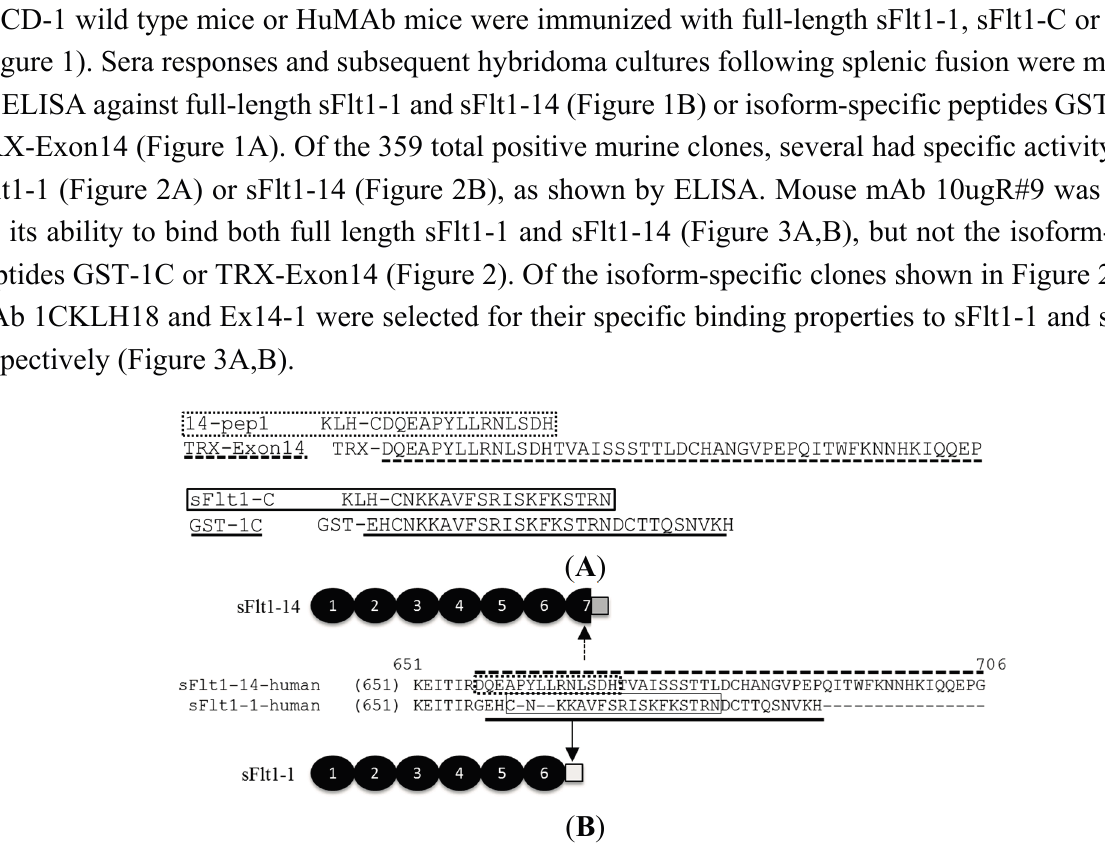
Figure 1. C -terminal peptide sequences used for generation of mouse mAbs specific to sFlt1-1 (solid line) and sFlt1-14 (dashed line). ( A ) A keyhole limpet hemocyanin (KLH) fusion protein preceded each sFlt1 peptide antigen used for immunizations while a Thioredoxin (TRX) or glutathione S -transferase (GST) tag preceded the sFlt1-14 and sFlt1-1 peptides, respectively, used for screening ELISAs. Full-length sFlt1-1 containing a C -terminal his tag was used to generate all other mouse mAbs and HuMAbs that recognize total sFlt1; ( B ) Schematic of sFlt1-14 and sFlt1-1 proteins identifying the unique epitopes antibodies were directed